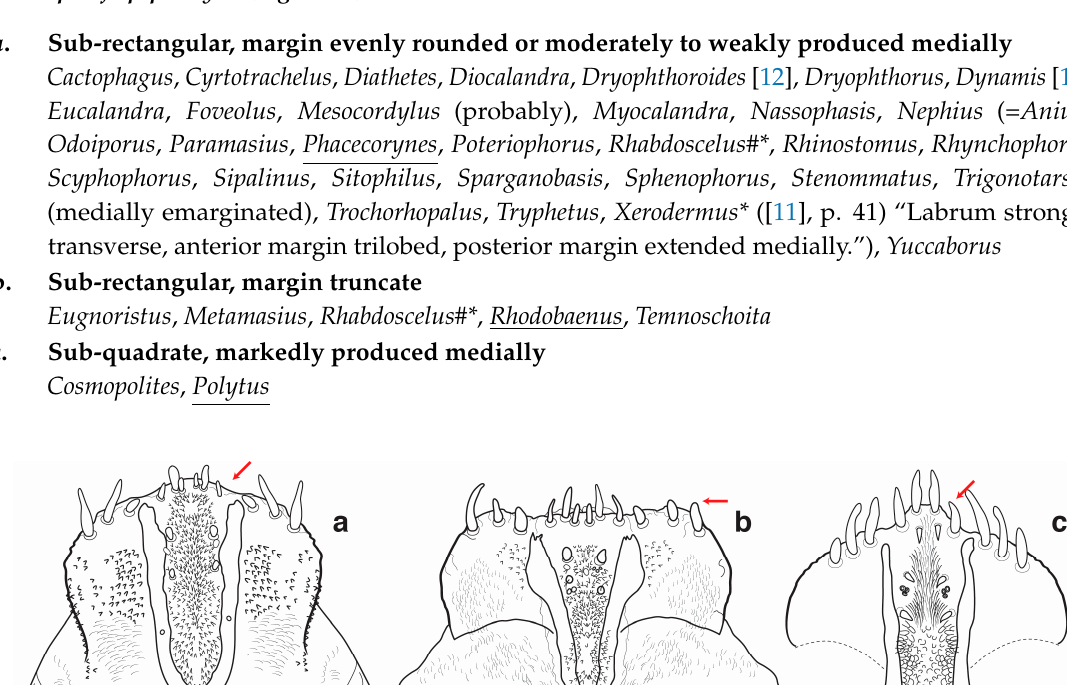
Figure 16. Labrum, larva: ( a ) Cosmopolites ; ( b ) Myocalandra ; ( c ) Rhodobaenus ; and ( d ) Sphenophorus maidis .